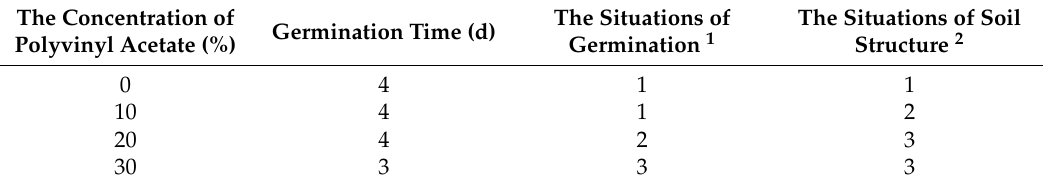
Figure 4. The images after germination: ( a ) the concentration of polyvinyl acetate ( C PVAc ) is 0%; ( b ) the C PVAc is 10%; ( c ) the C PVAc is 20%; ( d ) the C PVAc is 30%. Table 4. The situations of germination and the variation of soil structure.